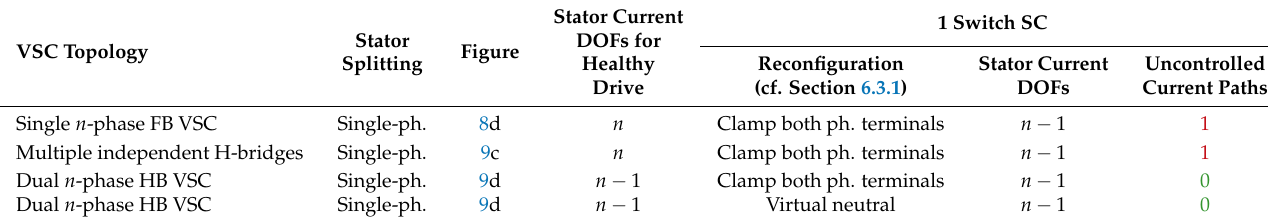
Table 32. Values obtained from Table 30 for the particular case of n = 6 with ξ = 1.